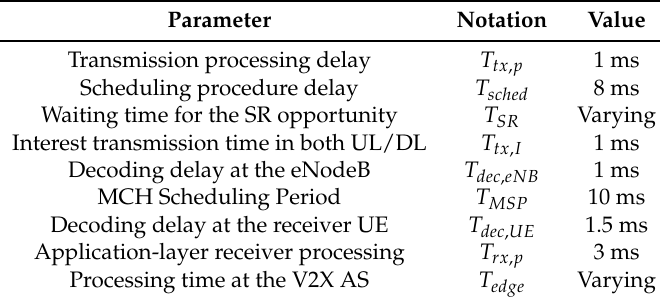
Table 2. Simulation